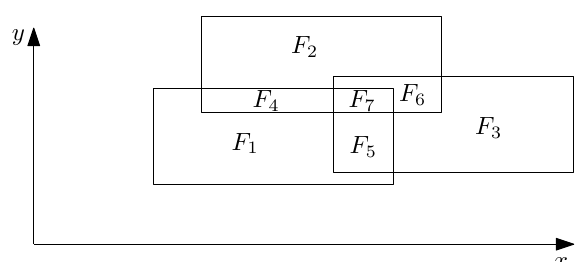
Figure 6. The seven faces of the arrangement formed by the three labels (cid:96) 1 , (cid:96) 2 , (cid:96) 3 in Figure 5. The number of instantiations of Constraint (8) equals the number of faces of A . To ensure that